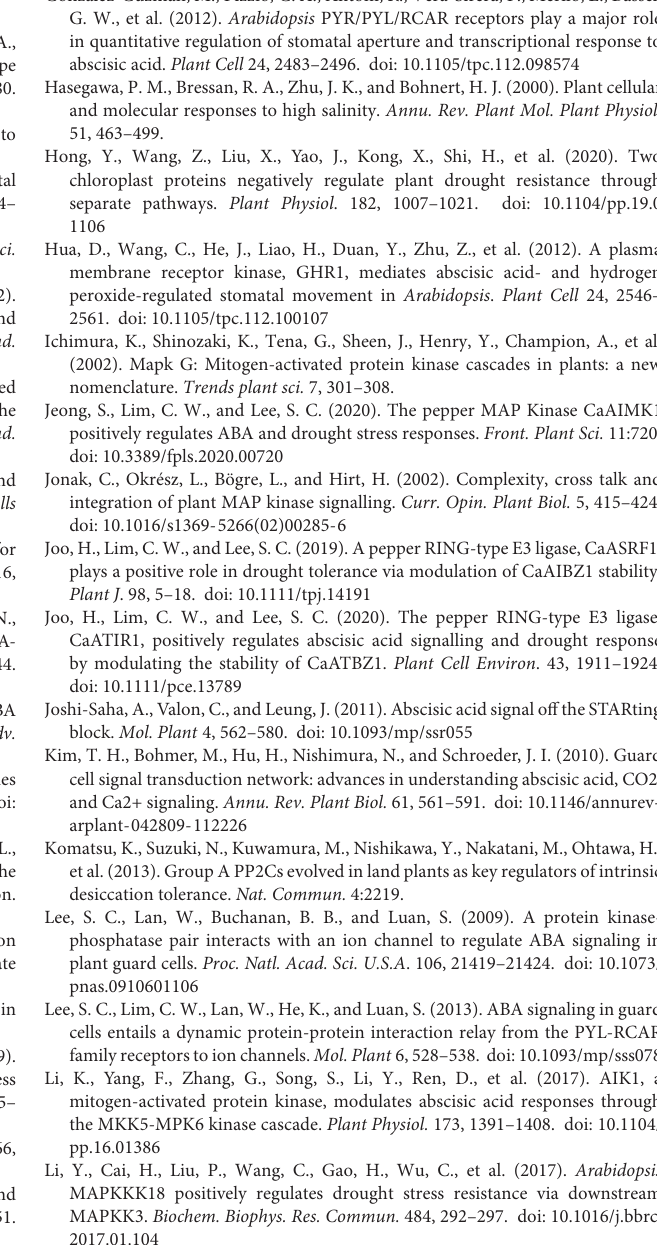
Supplementary Figure 1 | (A) Transcripts level of CaDIMK1 in the leaves of TRV2:00 and TRV2: CaDIMK1 plants. The CaACT1 gene was used as an internal